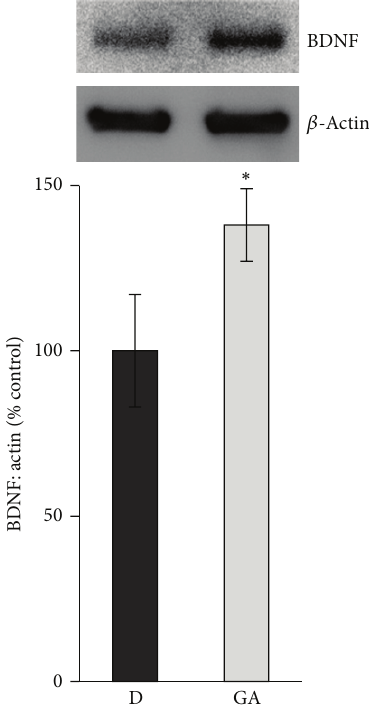
Figure 6: Diabetes-induced downregulation of brain-derived neu- rotrophic factor (BDNF) is prevented by constant intake of gly- cyrrhizic acid (GA) as shown by Western blot analysis. Each experiment was repeated 2 to 3 times with fresh samples ( 𝑛 = 6